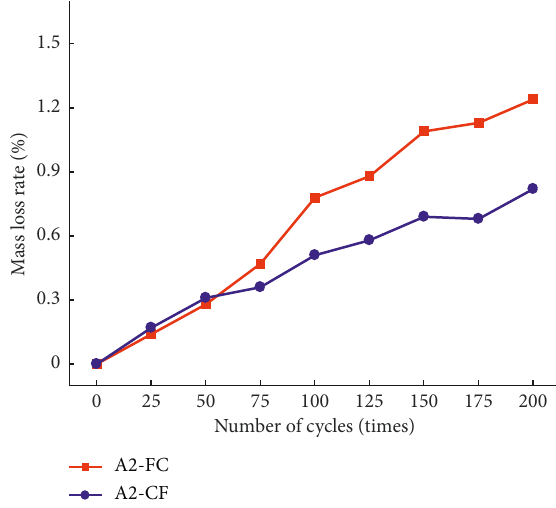
Figure 5: Mass loss rate of A2 subjected to alternative cycles of freeze-thaw and